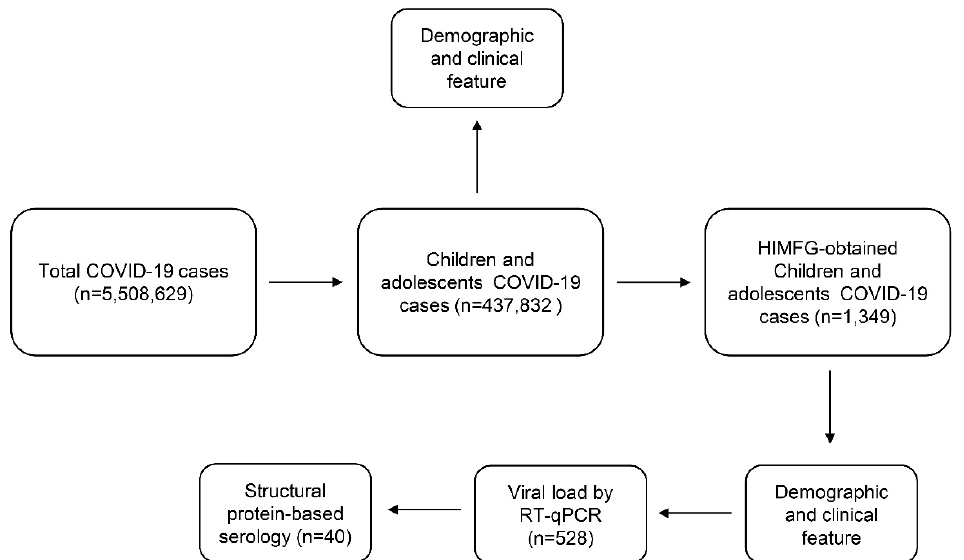
Figure 1. Flowchart of the study of children and adolescents in Mexico. From the beginning of the COVID-19 pandemic until 28 February 2022, 5,508,629 cases were diagnosed, of which 437,832 were children and adolescents. In the HIMFG, 1349 children and adolescents were admitted, where 528 were diagnosed by RT-qPCR. CTs were obtained of RT-qPCR outputs, and viral load was deter- mined as low, moderate, or high. Structural protein-based serology was performed on a small group of 40 children and adolescents.